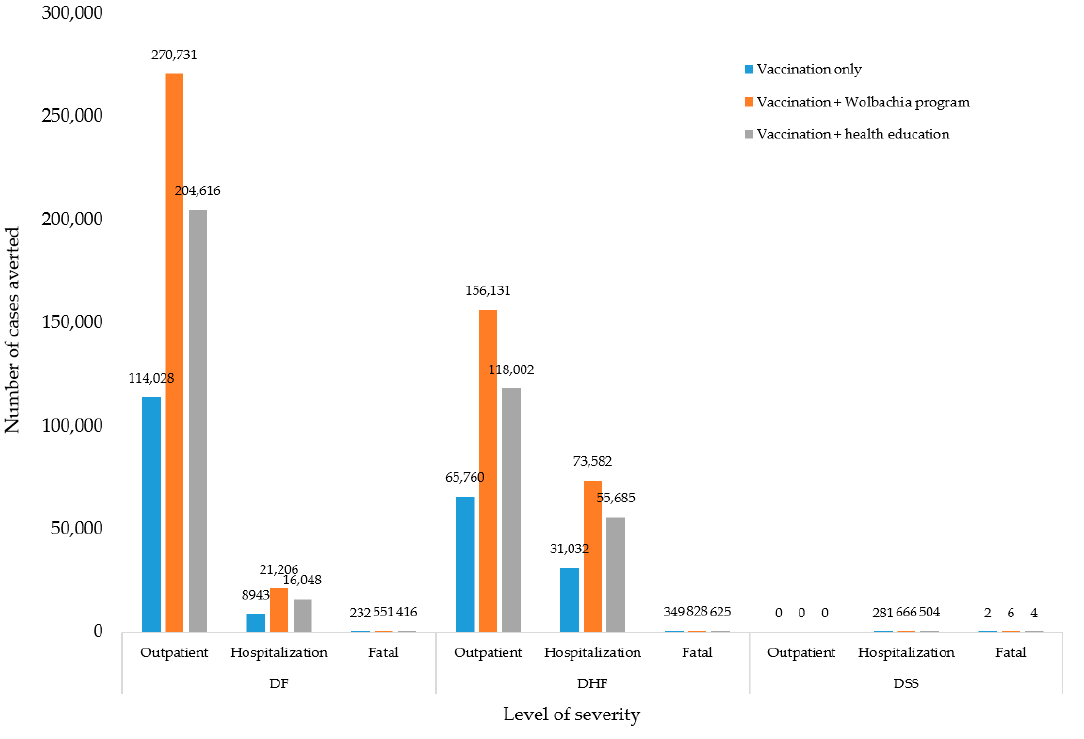
Figure 2. Number of cases averted.